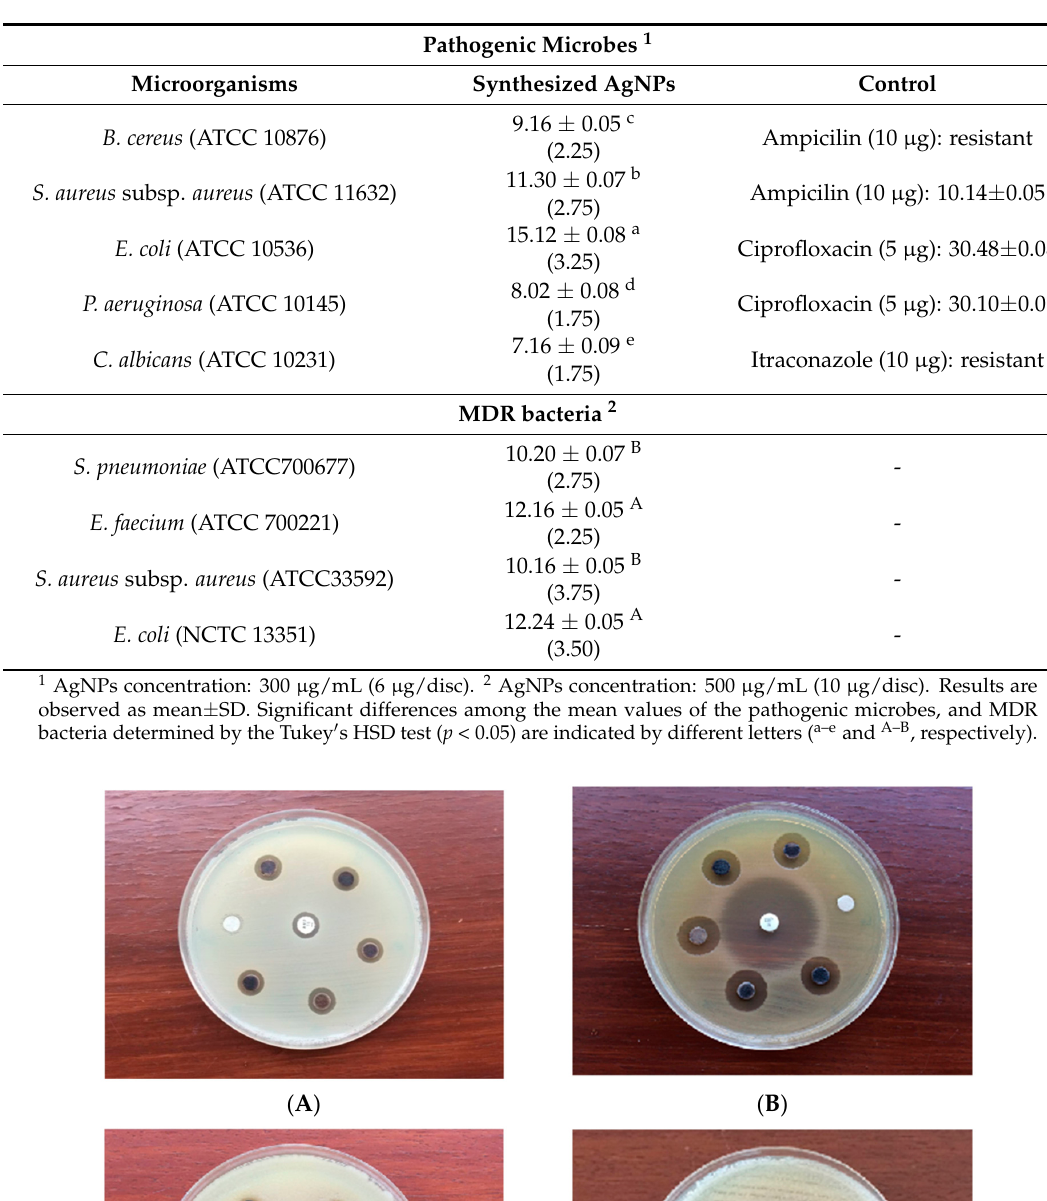
reported to reduce their toxicity [62]. No induced genetic toxicity in male and female rat bone marrow was observed for exposure to AgNPs at a high dose of 2.9 × 10 6 particles/cm 3 for 6 h/day by inhalation for 90 days in vivo [73]. Earlier it has been reported that AgNPs of different size and shape can impart equal cytotoxicity while exhibiting different antibacterial effects due to the differences in the dissolution rate. Hence, the exploration of the dissolution rate difference of AgNPs has been suggested for application of these nanoparticles with a relatively higher bacterial effect while minimising cytotoxic effects towards normal tissues [74]. It has been reported earlier that AgNPs have potential antimicrobial efficiency against MDR microbes [66] as well as pathogenic microbes [21,44,45,75,76]. It is therefore, understood that the AgNPs synthesized in the present study could lead to a more significant antimicrobial efficiency against a wide range of pathogenic microbes and MDR pathogens at a higher level of concentration. In that instance, it is advised to consider the in vivo toxicity of the AgNPs as they may cause genotoxic and epigenetic changes in human beings [77] and impairment to ecosystems [78]. However, to the best of our knowledge, the present study is the first ever to report on the potential of AgNPs against these pathogenic microbes and MDR bacteria.